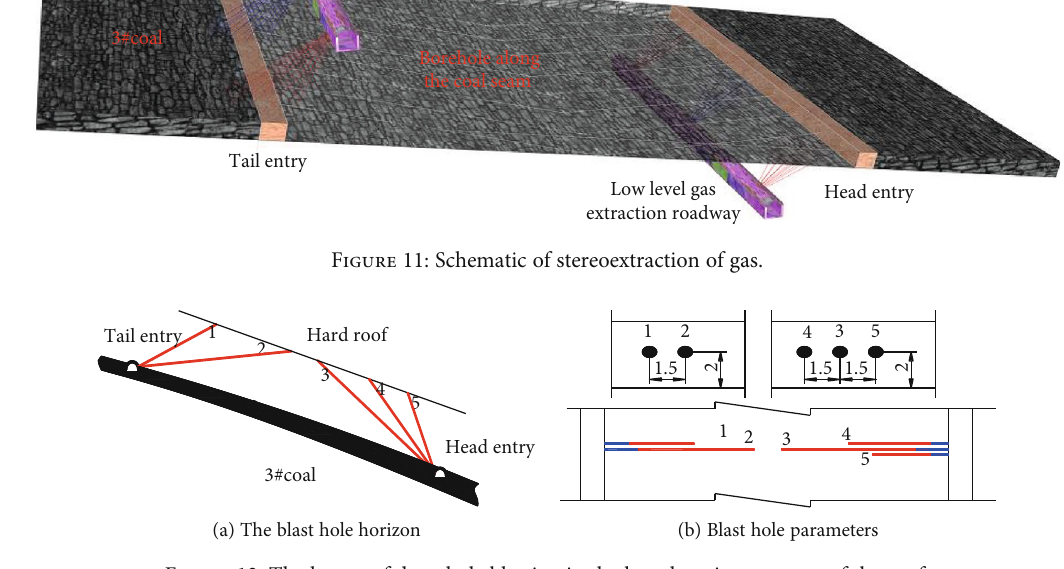
Figure 12: The layout of deep-hole blasting in the long hanging segment of the roof. Table 3: Technical parameters of deep-hole blasting in long hanging